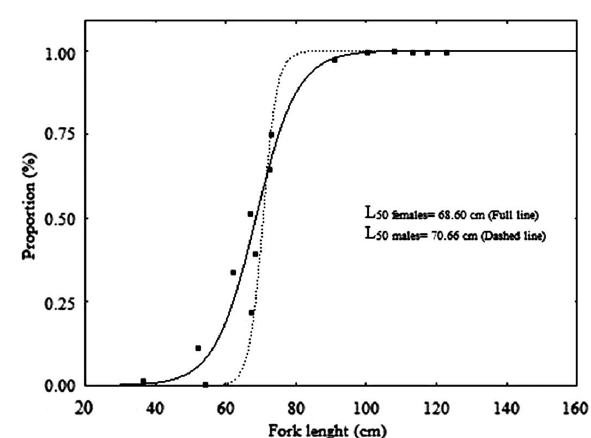
Fig. 7. – Length at first sexual maturity L for males (n=175) and 50 females (n=361) of Coryphaena hippurus caught in the vicinity of the Saint Peter and Saint Paul Archipelago between 2007 and